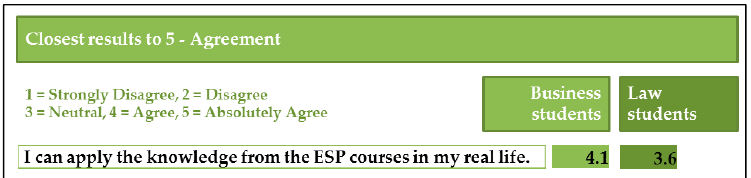
Figure 5. Business students’ and Law students’ opinions towards the application of ESP in real life.